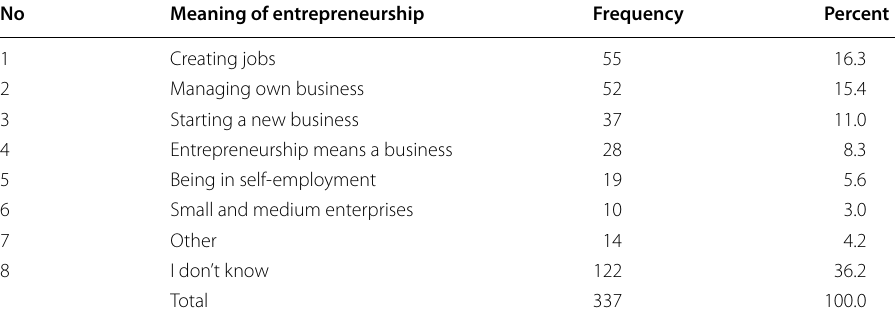
Table 2 Results of content analyses of definitions of entrepreneurship No